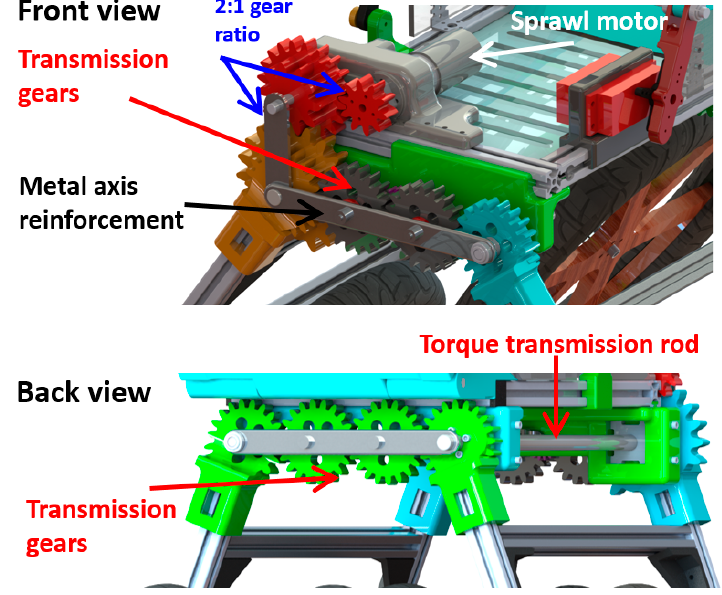
Figure 6. The sprawl mechanism. Front and back views.